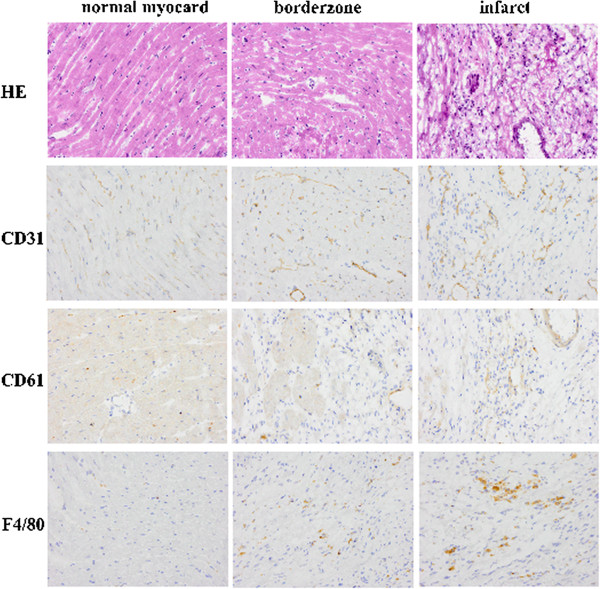
Representative myocardial sections. HE, CD31 (endothelial cells), CD61 (β3 integrin) and F4/80 (macrophages) staining in infarct, border zone and remote areas. Original image ×400 magnification.